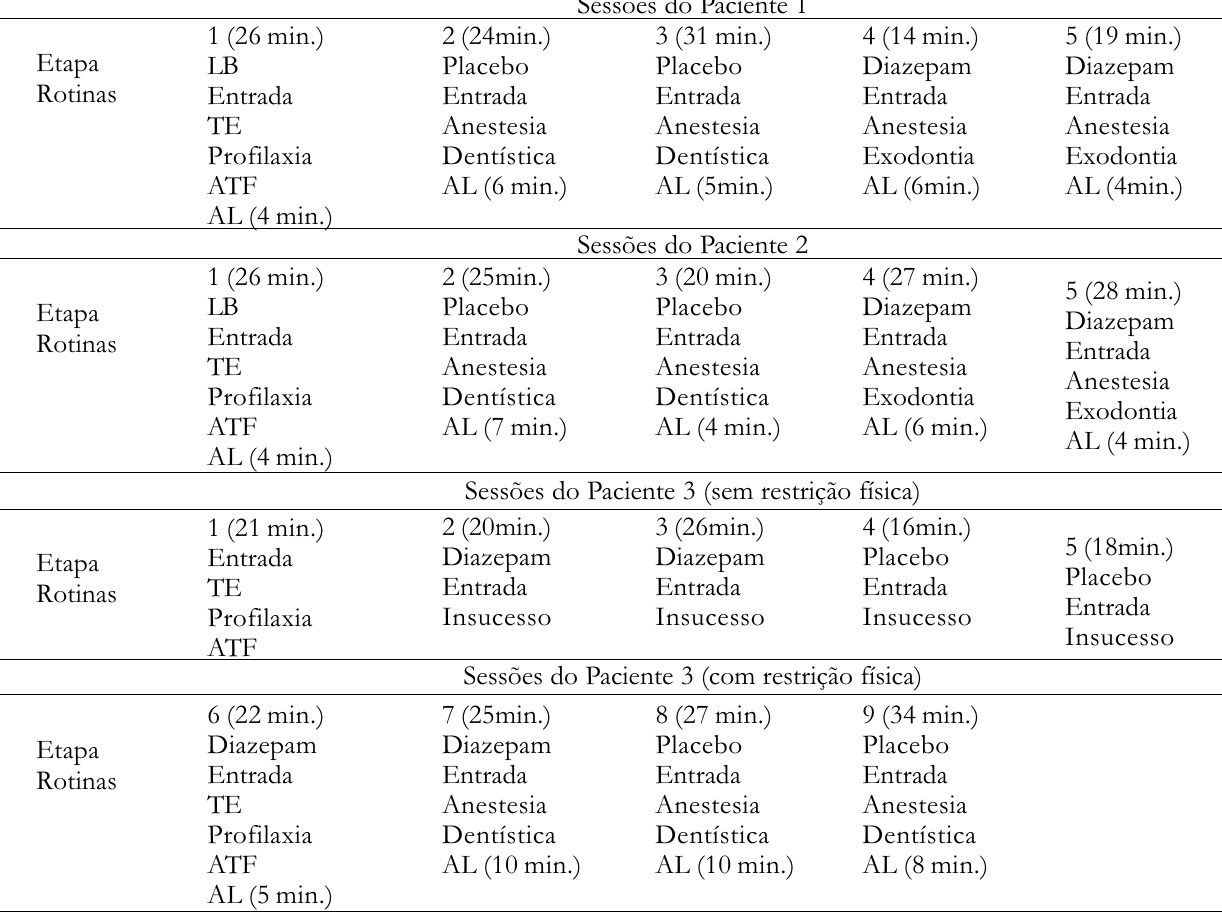
A Figura 1 apresenta as freq(cid:252)Œncias acumuladas de categorias de comportamento da dentista e do paciente P3